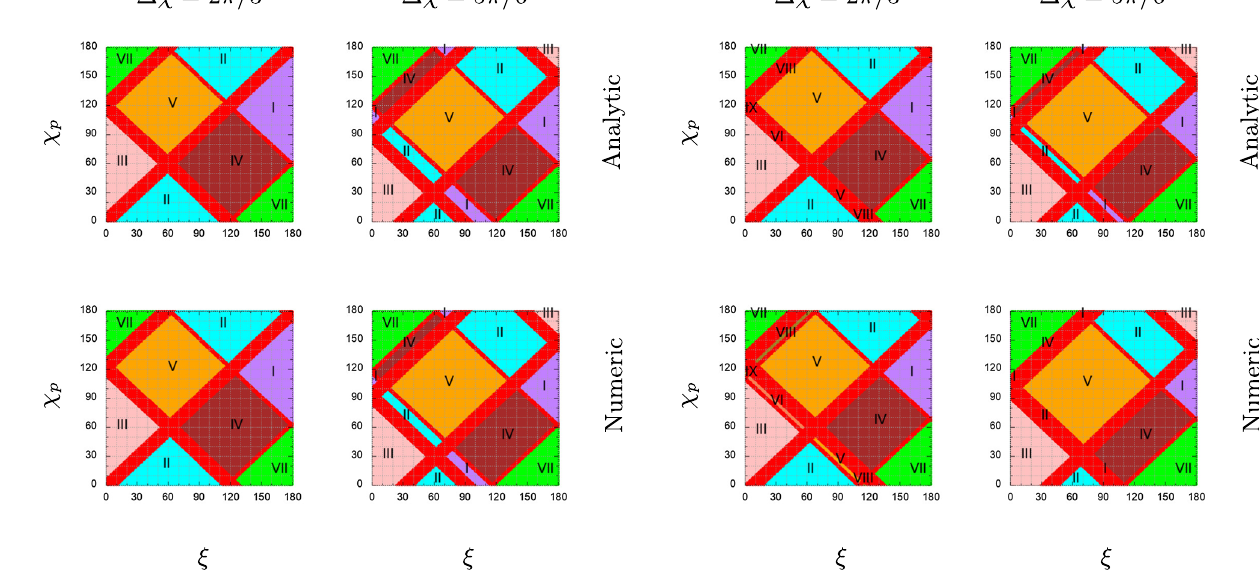
being the maps symmetric with respect to the straight lines ξ = 0 and ξ = 180 o , that is, Class (π + δ, χ ) . On the other hand, we have that Class (ξ, π + δ) δ, χ p